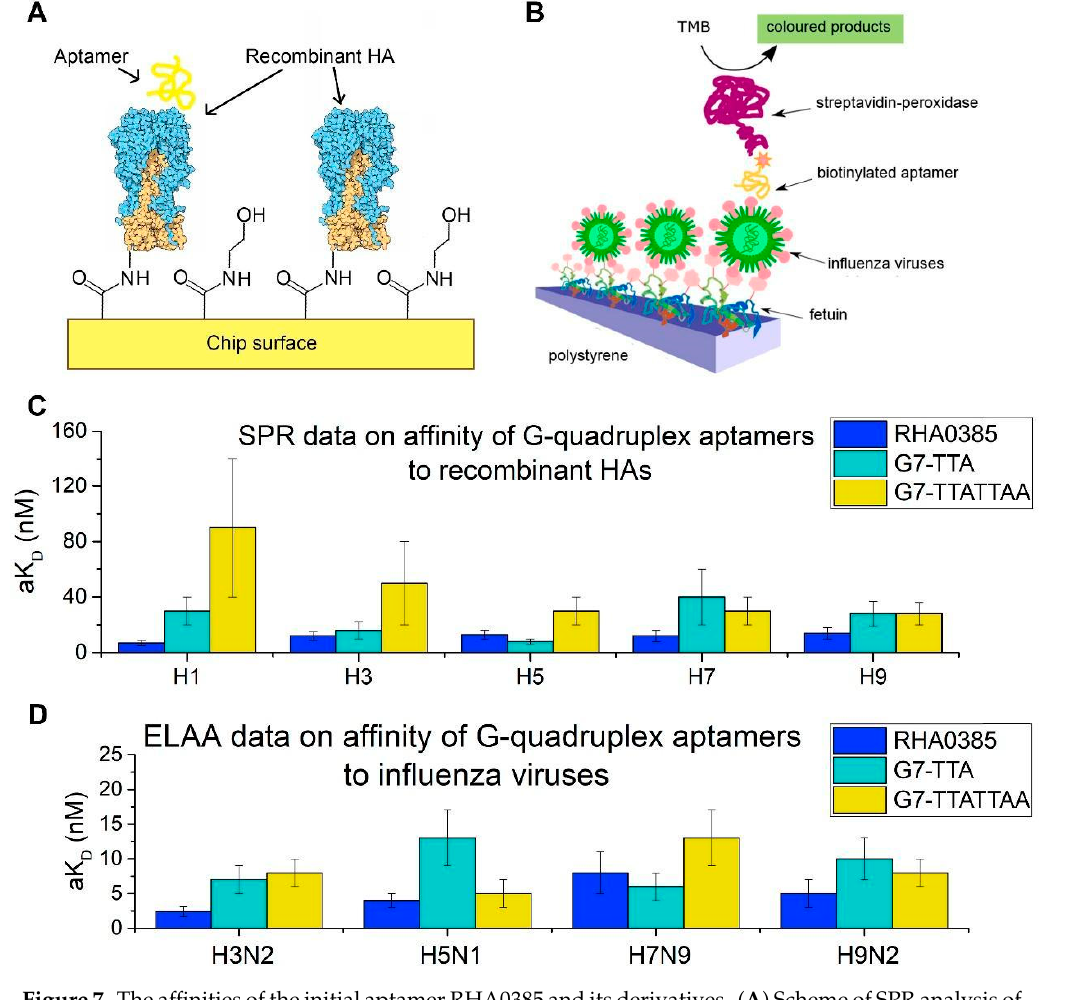
Figure 7. The a ffi nities of the initial aptamer RHA0385 and its derivatives. ( A ) Scheme of SPR analysis of interaction between the aptamer and the recombinant HAs. ( B ) Scheme of ELAA analysis of interaction between the aptamer and the influenza virus particles. ( C ) SPR data on a ffi nities of G-quadruplex aptamers to recombinant HAs from H1, H3, H5, H7, H9 serotypes. ( D ) ELAA data on a ffi nities of G-quadruplex aptamers to the di ff erent strains of the influenza A viruses: A / England / 42 / 1972 (H3N2), A / chicken / Kurgan / 3654at / 2005 (H5N1), A / mallard / Sweden / 91 / 2002 (H7N9), A / duck / Primorie / 3628 / 2002 (H9N2).